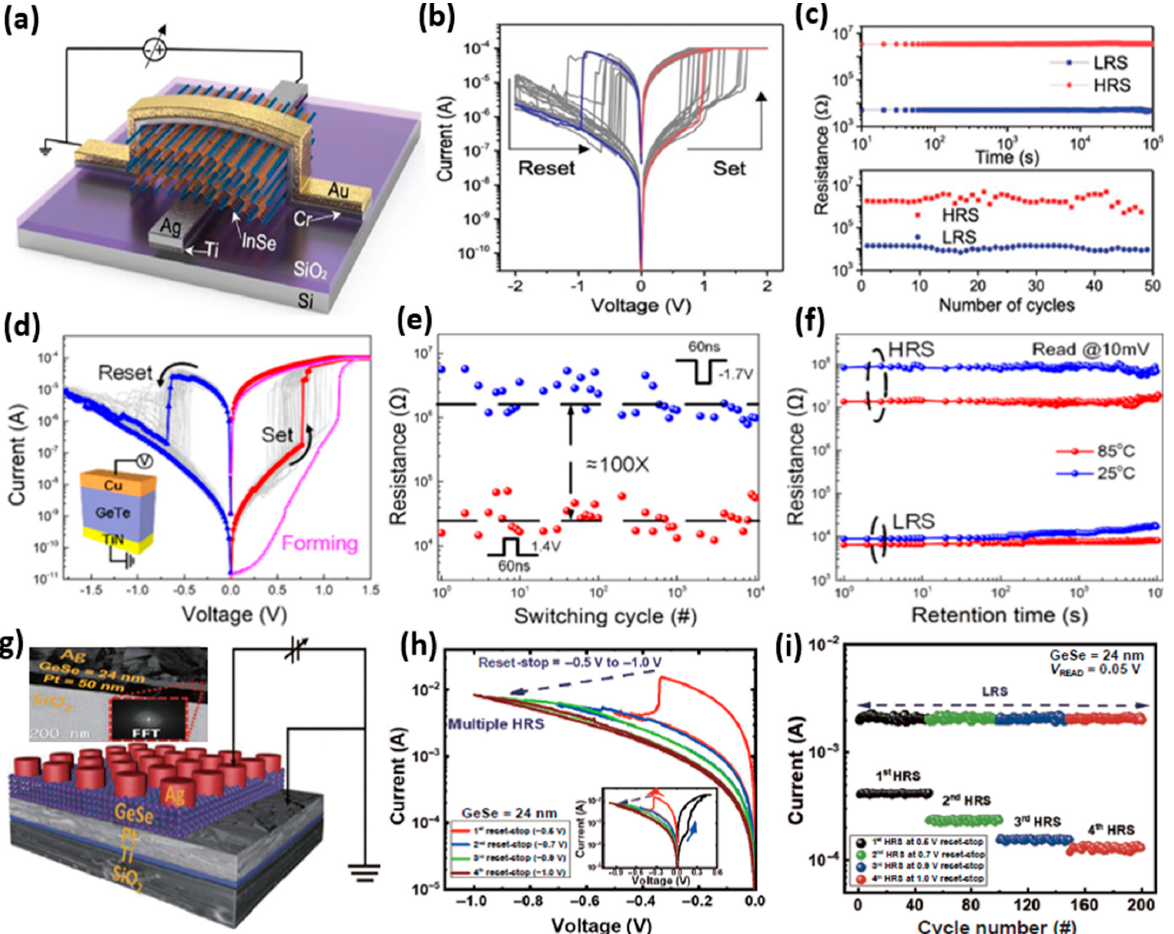
Figure 5. The CBRAM devices with chalcogenide-based switching materials. ( a ) The schematic diagram of a CBRAM device with InSe 2D monochalcogenide switching layer, ( b ) its typical I–V characteristics presenting bipolar switching, and ( c ) its retention and endurance characteristics. Reprinted from Ref. [50]. ( d ) The typical I–V characteristics of a CBRAM device with structure Cu/GeTe/TiN presenting bipolar switching. The inset shows the schematic of the device structure. ( e ) The endurance characteristics of the Cu/GeTe/TiN device. ( f ) The retention characteristics of the Cu/GeTe/TiN device. Reprinted from Ref. [21]. ( g ) The schematic diagram of a CBRAM device with a monochalcogenide GeSe switching layer and a cross-sectional TEM image of the device. ( h ) The I–V characteristics of the 24 nm GeSe-based device presenting multilevel switching and ( i ) the endurance characteristics of the multiple resistance states. Reprinted from Ref. [23].